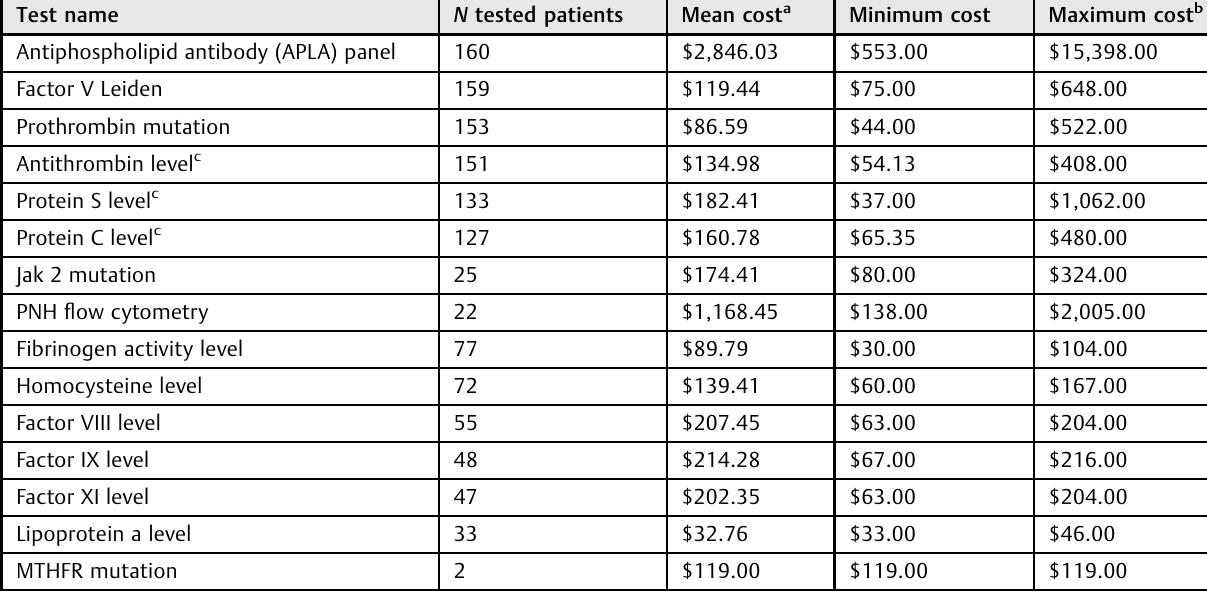
Table 2 Direct medical costs of thrombophilia testing at Emory University Hospitals (in US